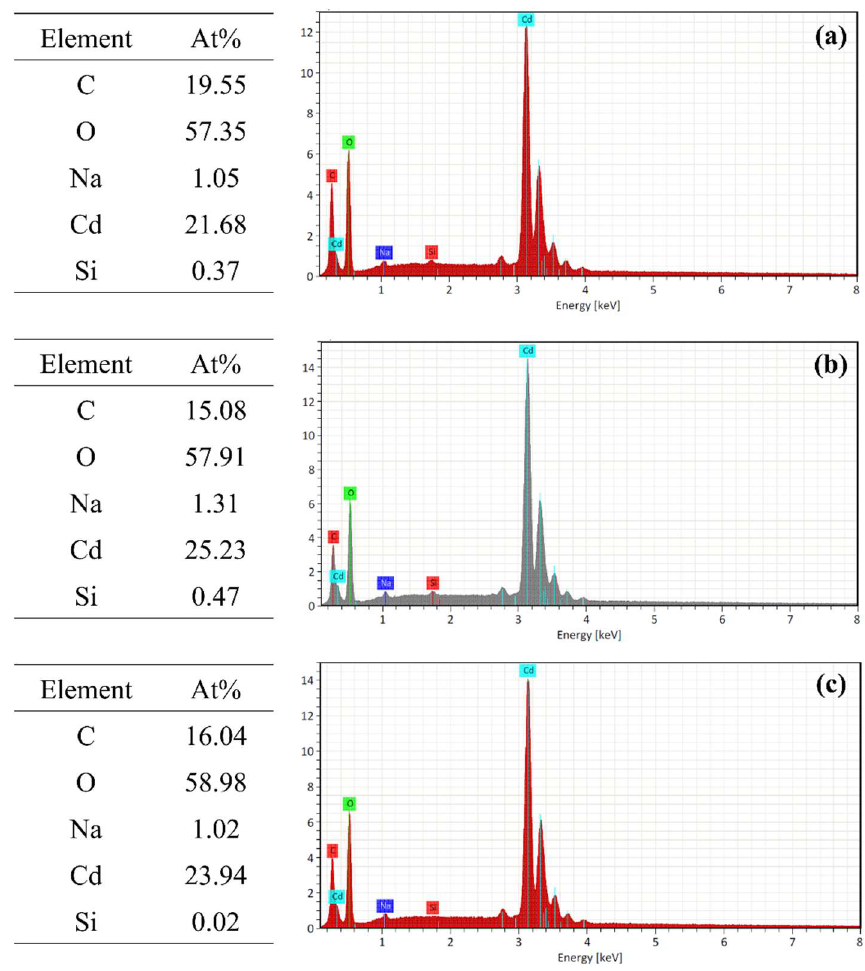
Figure 6. EDS spectra of the samples at deposited ( a ) 10, ( b ) 11, and ( c ) 12 h.